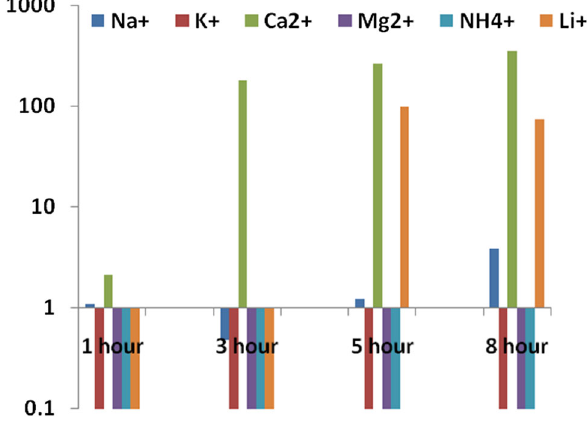
Fig. 9 Change in concentration of cations (in ppm) in aqueous leachates of Ledo coal (LC-20A) with leaching time (in hour) at 65 (cid:3) C